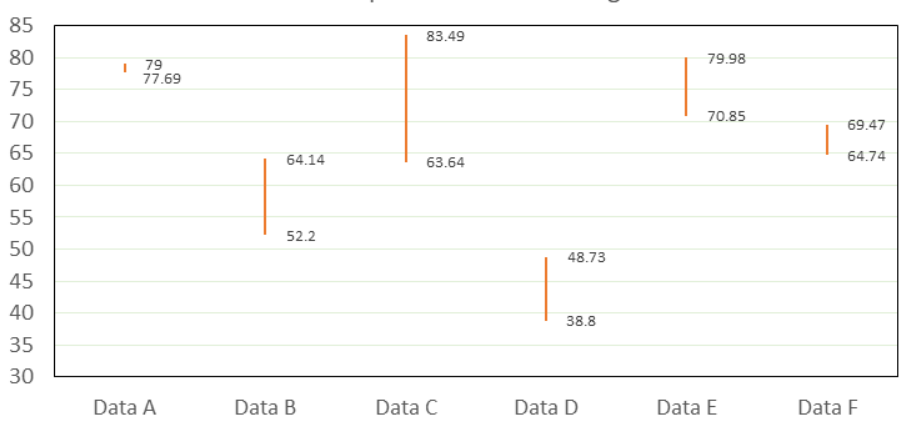
Figure 8. The optimal threshold range of Data A – F.